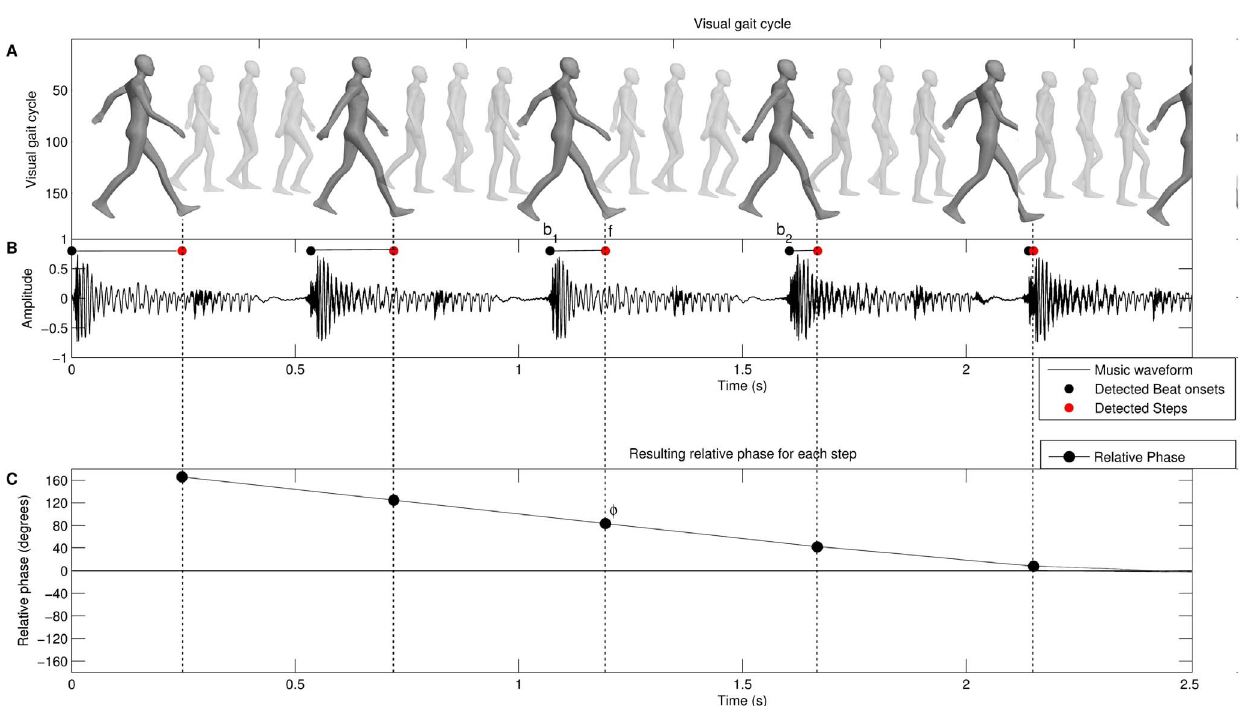
Fig. 3. Relative phase of walking on music. Figure A shows the visual gait cycle for left and right steps, figure B shows the waveform of the music with annotated beats. Finally, figure C shows the resulting relative phase which expresses the timing difference between footfalls (A) and musical beat